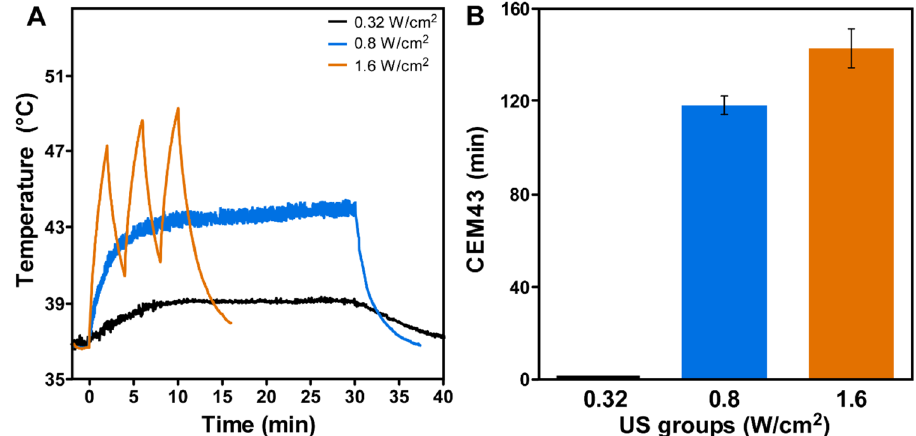
Figure 4. Tumor temperature and thermal dose (CEM43) measurement. ( A ) Graphs showing tumor temperature in live mice during US treatment at 0.32, 0.8 and 1.6 W/cm 2 . Black line represents 0.32 W/cm 2 US; blue line represents 0.8 W/cm 2 US; and orange represents 1.6 W/cm 2 US. ( B ) Graph showing thermal dose (CEM43) measured for three different ultrasound treatment